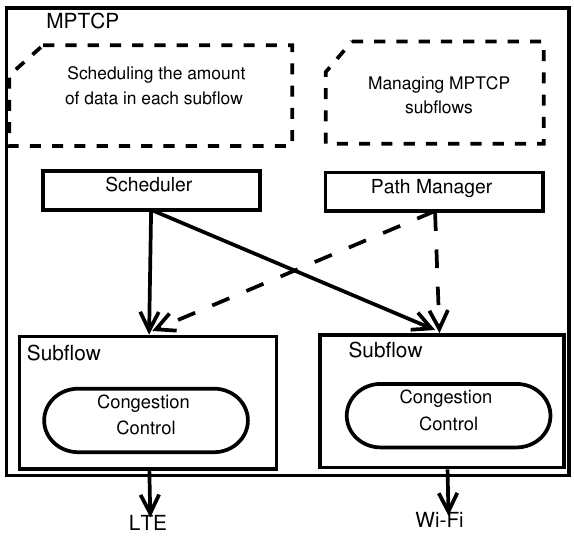
Figure 1. Software Component in